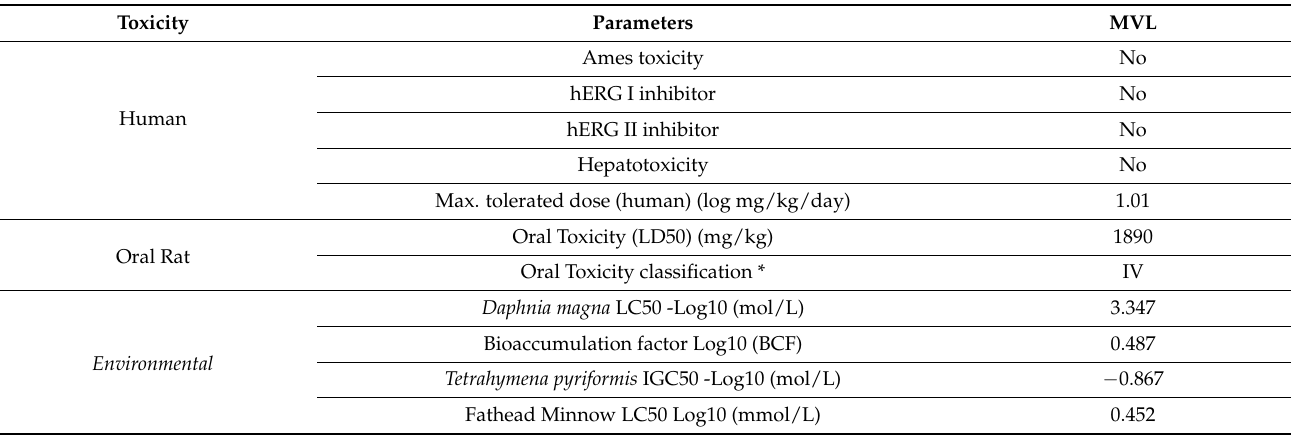
Table 6. Predicted Human, Oral rat, and Environmental toxicity profile of MVL.